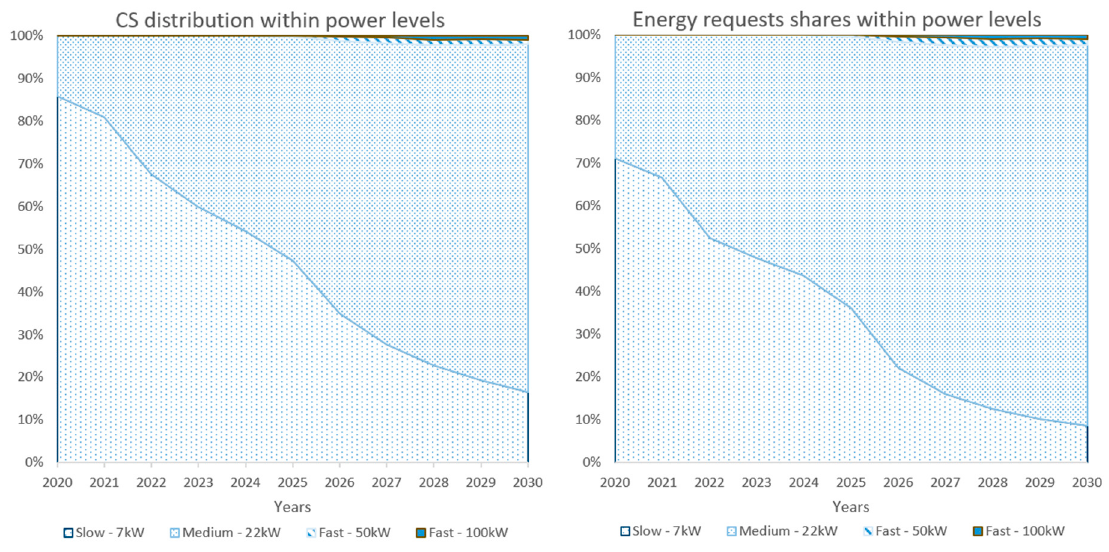
Figure 9. CS distribution (left) and energy requests distribution within power level (right) for the publicly accessible charging infrastructure.